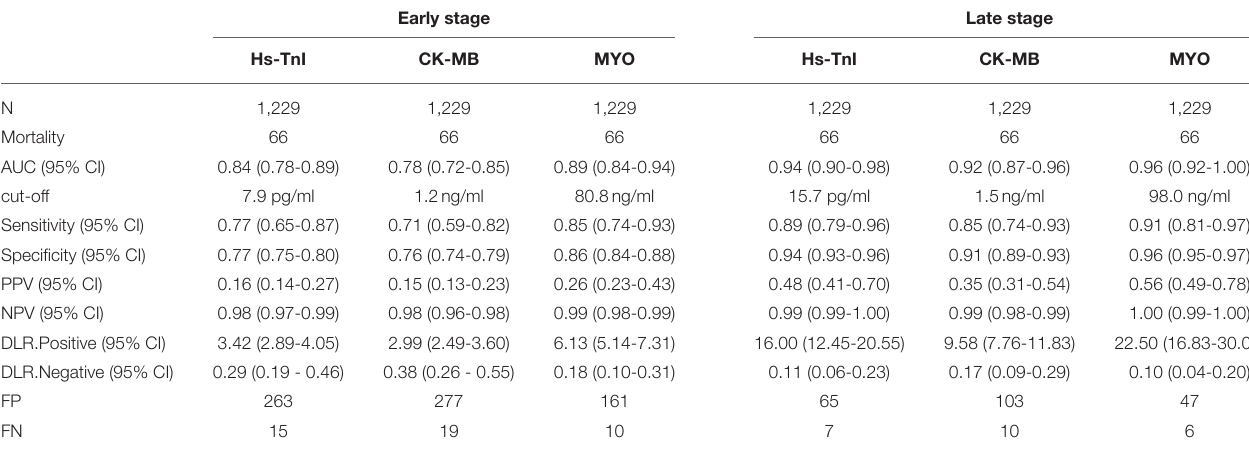
TABLE 3 | Overall performance of the myocardial biomarkers according to the standard ROC